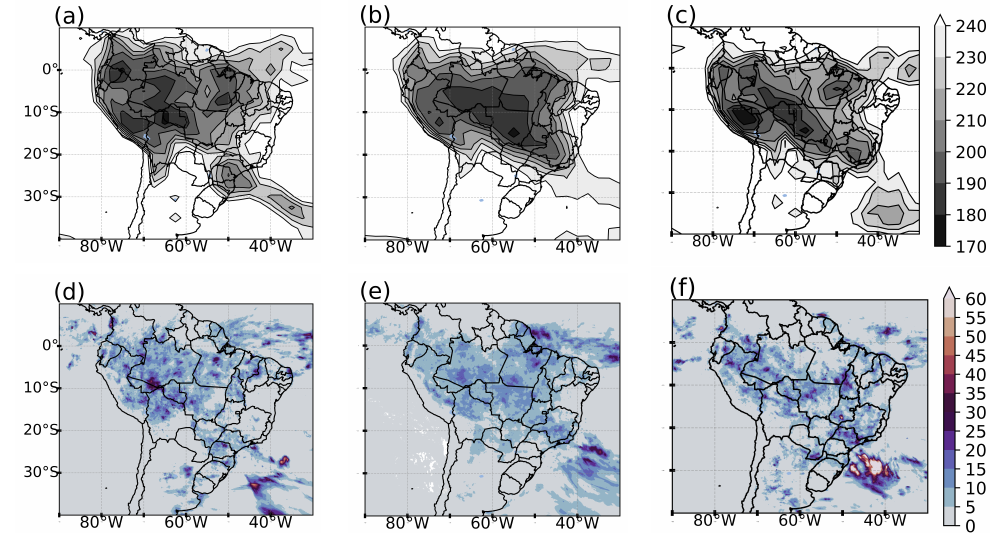
Figure 3. Composites of the OLR (W · m − 2 ) ( a – c ) and precipitation (mm · day − 1 ) ( d – f ) for − 3D (left), 0D (center), and +2D (right) panels of the SACZ events during the active phase of the